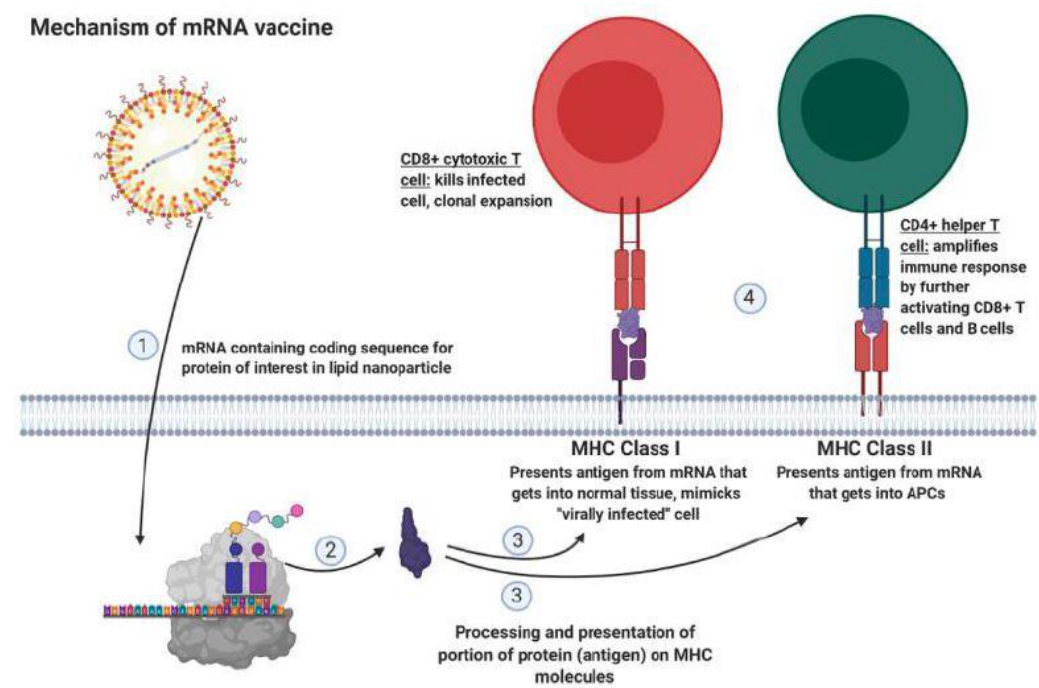
Figure 4. Mechanism of mRNA vaccine utilized in cancer therapeutics and COVID-19 prevention. The mRNA containing the coding sequence for the target protein is protected by lipid nanoparticles in order to ensure proper delivery to cells (1). Once the mRNA is inside cells, the intracellular machinery will translate the mRNA into the protein of interest (2). Then, this protein is processed as a foreign invader, which enables portions of the protein (antigens) to be presented on MHC class I by nucleated cells or class 2 by antigen presenting cells (3). MHC class I presentation generates killing of the cell as well as clonal expansion of the CD8+ T cell (4). MHC class II presentation induces the CD4+ helper T cell-dependent amplification of the immune response by further activating T cells and antibody secreting B cells (4). This mechanism, popularized by the recent invention of COVID-19 vaccines, has been previously utilized in cancer immunotherapy.